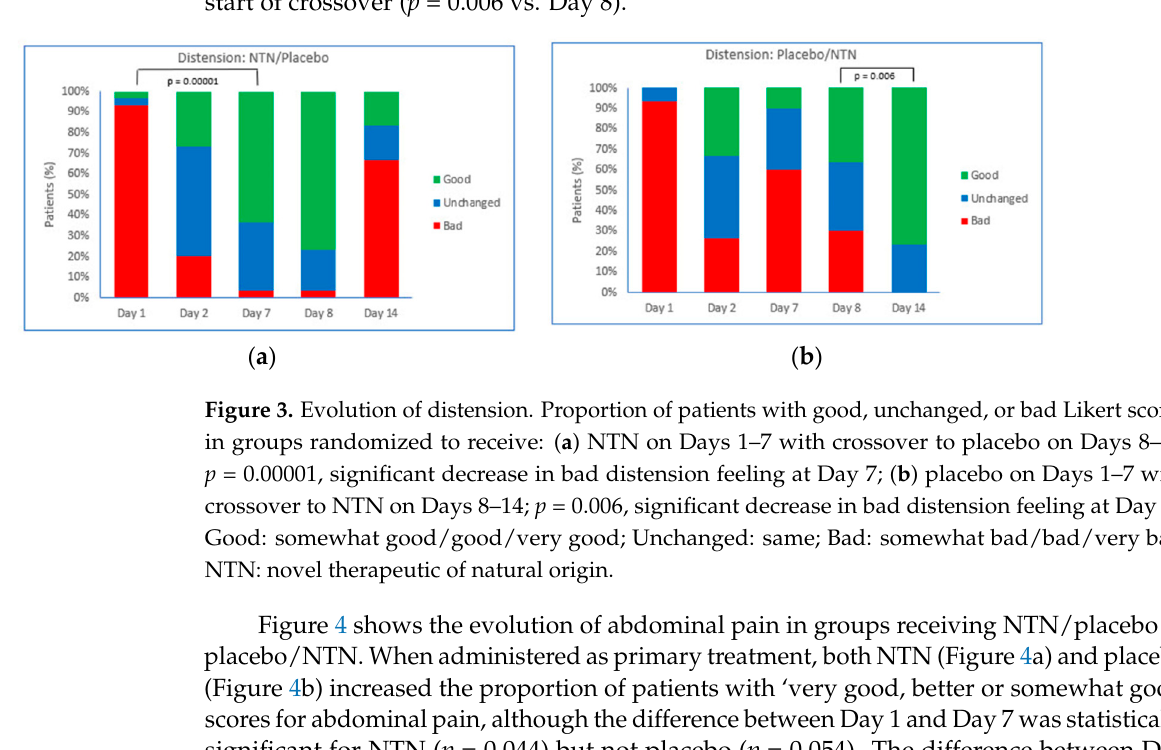
( p = 0.002 vs. Day 8), and no patients reported bad symptoms compared with 30% at the start of crossover ( p = 0.006 vs. Day 8).